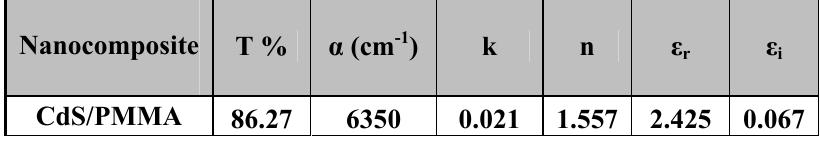
Table 1: The optical parameters for CdS/PMMA thin film at ( λ =550) nm.